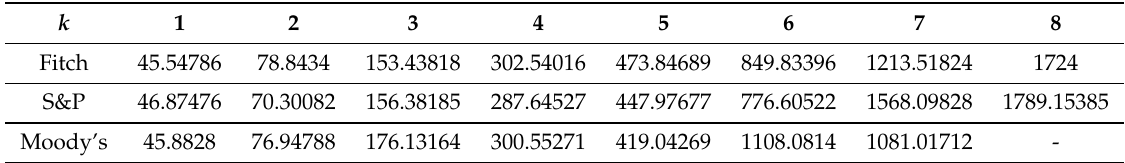
Table 4. Average value of the credit spread distribution